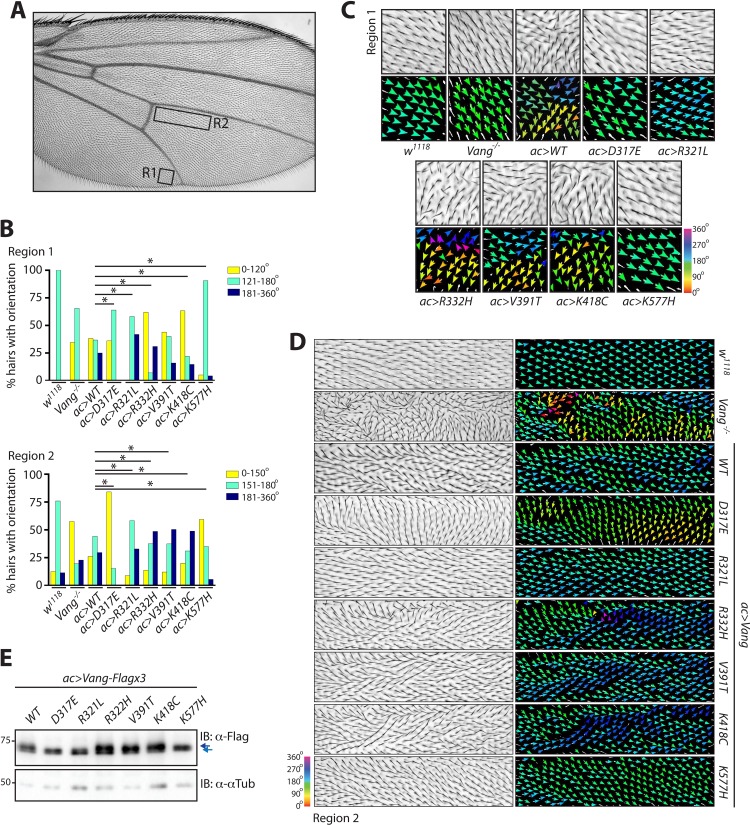
Behavior of over-expressed Drosophila Vang carrying C-terminal mutations.(A) Overview of an adult wing highlighting the analyzed regions of hair reorientation. (B) Quantification of the percentage of actin hairs oriented within a specific angle range upon actin-Gal4 driven overexpression (ac>) of the different Vang mutant proteins and wild-type Vang. Also included for comparison is Vang-/- and w1118 (a genetically wild-type wing that displays no phenotype). Graph is shown for region 1 (upper) and region 2 (lower). Angles from three independent wings were combined, and data binned to allow analysis using a Chi-squared test. * indicates p<0.001 (C) Example images of hair reorientation in region 1 in the indicated genotypes. Top panel shows adult wing, bottom panel shows the corresponding angles of hair orientation visualized through color (see 360 degree color scale, bottom right). Angles were determined using the Fuji plugin FijiWingsPolarity (Dobens et al., 2018). (D) Example images of hair reorientation in region 2. Left panel shows adult wing, and right panel the corresponding angles of hair orientation. (E) Western blot of wing disc lysates from the indicated genotypes. While similar levels of expression are observed, a difference in Vang mobility is notable for D317E, R321L and K577H, as indicated by blue arrows.Figure 2—source data 1.Raw data from the quantification of hair reorientation summarized in Figure 2.